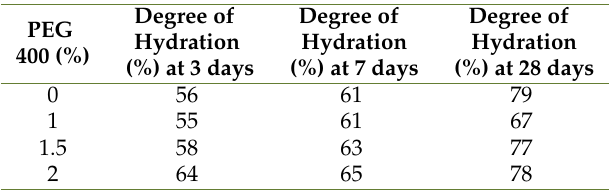
Table 3. Degree of Hydration at 0.34 Water-Cement